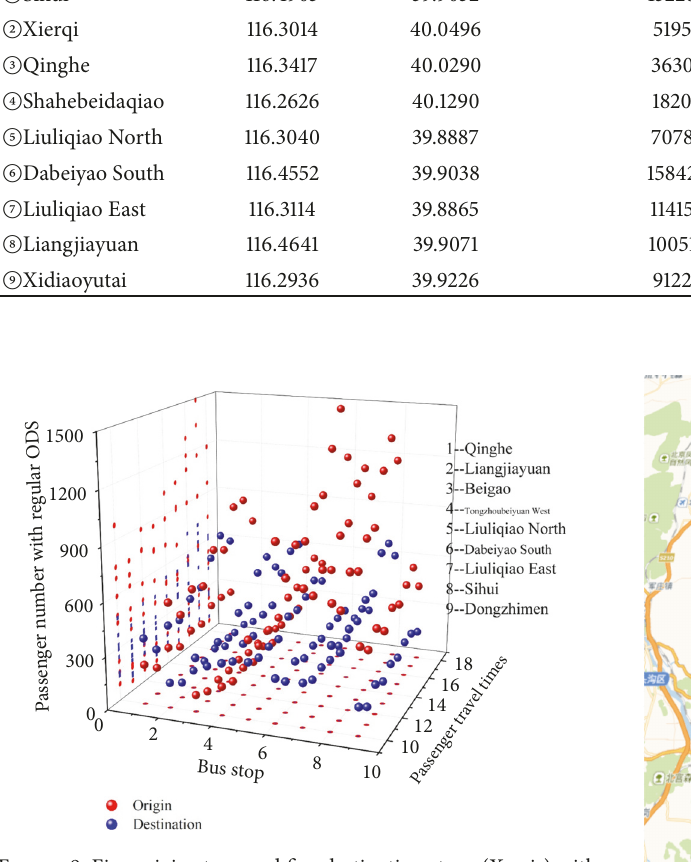
Figure 9: Five origin stops and five destination stops (X axis) with the largest passenger number with regular ODs (Z axis) in the evening for different travel times (Y axis).